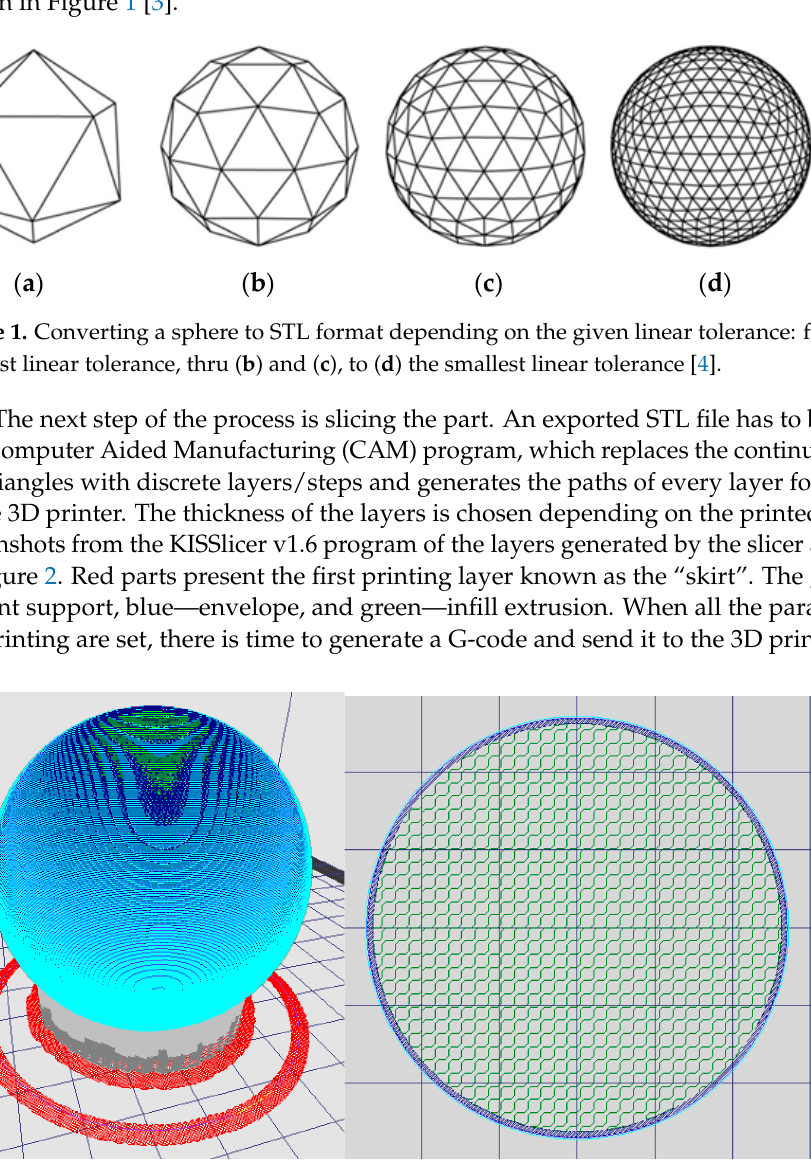
Figure 2. Paths generated in CAM program.